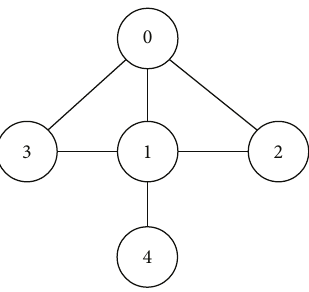
Figure 1: Communication topology of the leader-following